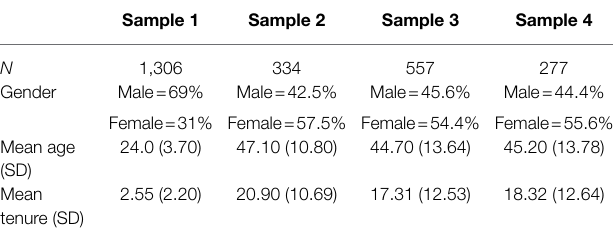
TABLE 1 | Descriptive statistics of study